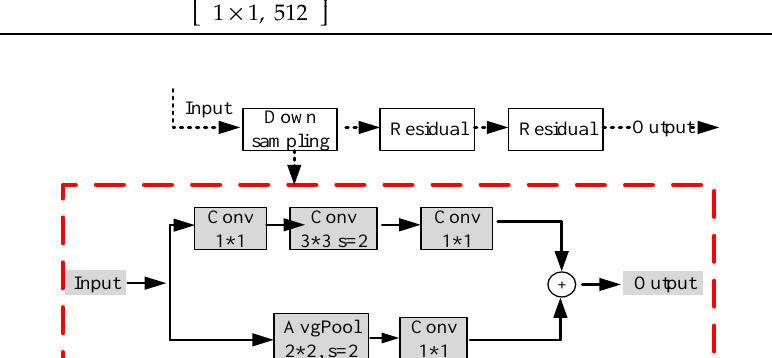
Table 1. Backbone for Resnet_50.